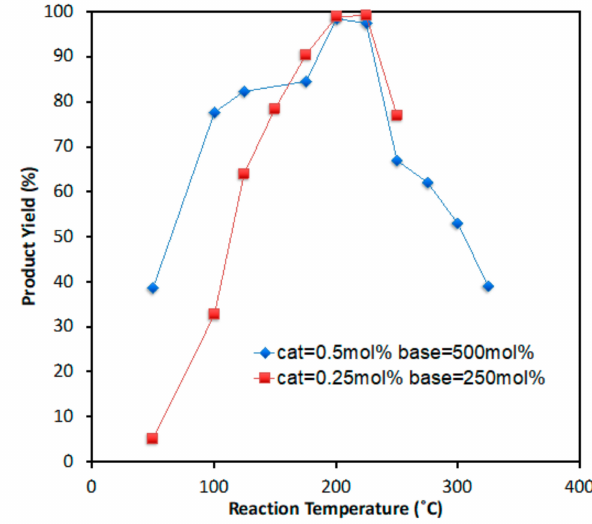
Figure 2. The effect of the reaction temperature for yield of 3 by SMC in HPHT water at the different concentrations of catalyst; (cid:7) : 0.5 mol % of PdCl 2 , 500 mol % of NaOH, (cid:4) : 0.25 mol % of PdCl 2 , 250 mol % of